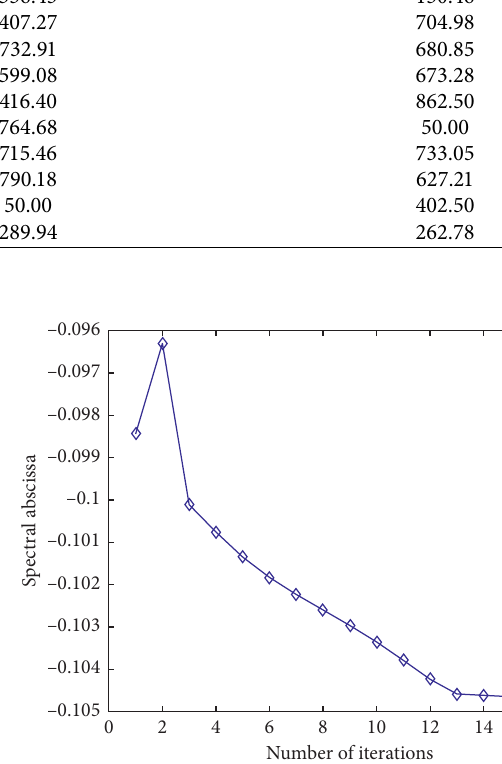
Figure 3: Spectral abscissa changes with iterations for the 118-bus system.